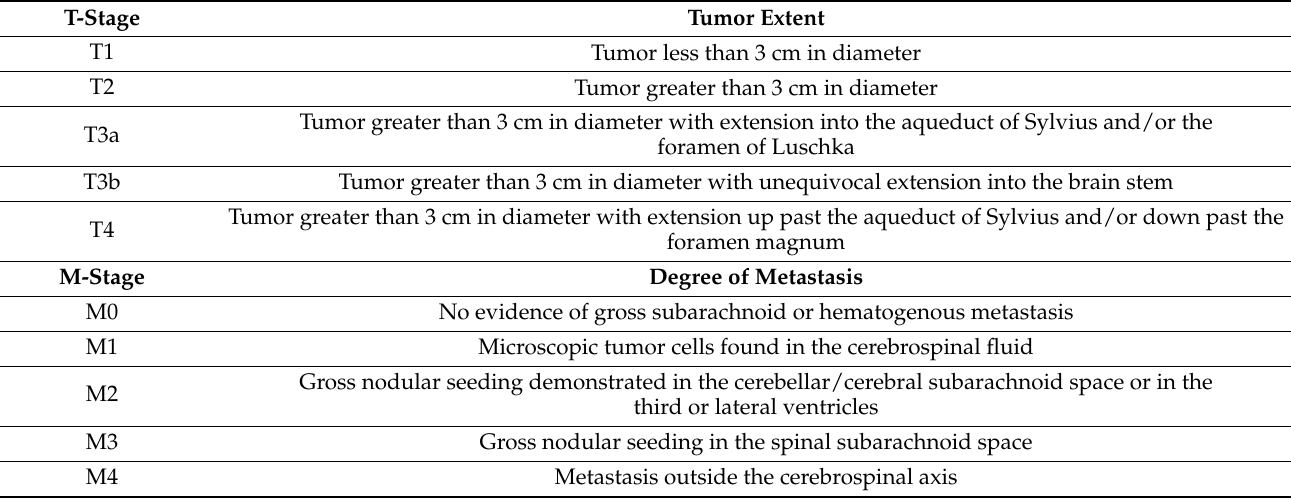
Table 3. Modified medulloblastoma staging system according to